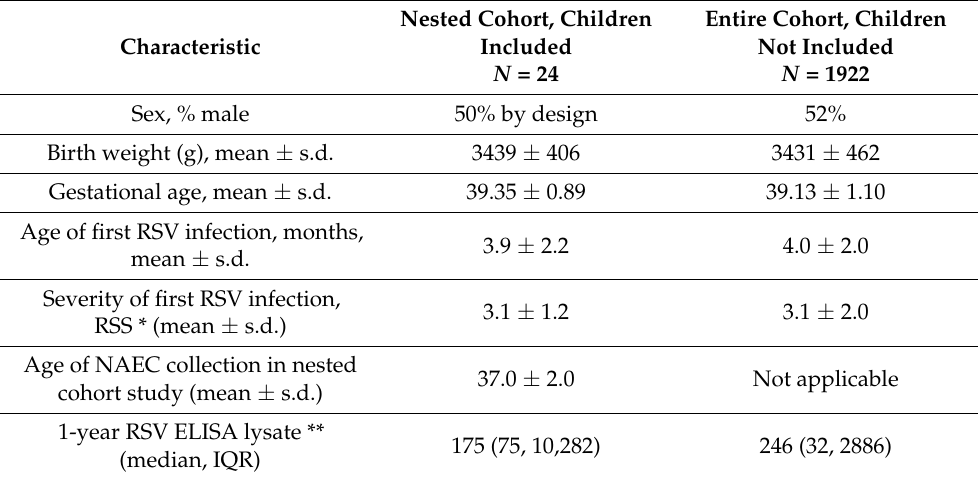
Table 1. Comparison of demographic, biospecimen collection, and clinical characteristics of children included in this nested cohort study from among those in the larger INSPIRE cohort. Entire Cohort, Children Nested Cohort, Children Not Included Characteristic Included N = 1922 N = 24 Sex, % male 50% by design 52% Birth weight (g), mean ± s.d. 3439 ± 406 3431 ± 462 Gestational age, mean ± s.d. 39.35 ± 0.89 39.13 ± 1.10 Age of first RSV infection, months, 3.9 ± 2.2 4.0 ± 2.0 mean ± s.d. Severity of first RSV infection, 3.1 ± 1.2 3.1 ± 2.0 RSS * (mean ± s.d.) Age of NAEC collection in nested 37.0 ± 2.0 Not applicable cohort study (mean ± s.d.) 1-year RSV ELISA lysate ** 175 (75, 10,282) 246 (32, (median, IQR)